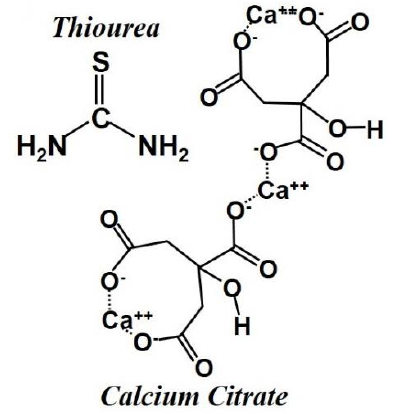
Figure 1. Chemical structures of calcium citrate and thiourea.